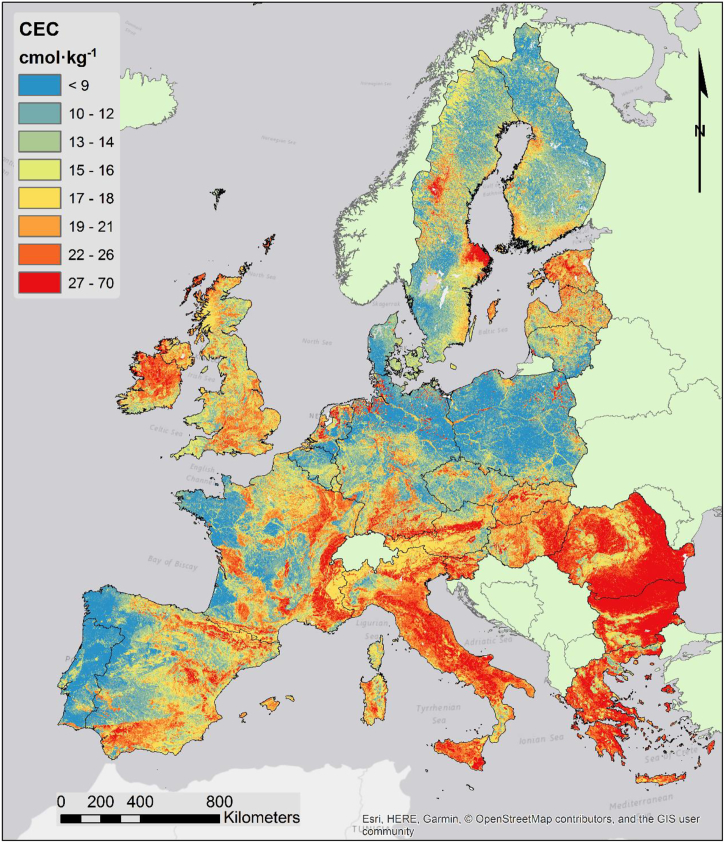
Map of topsoil CEC.